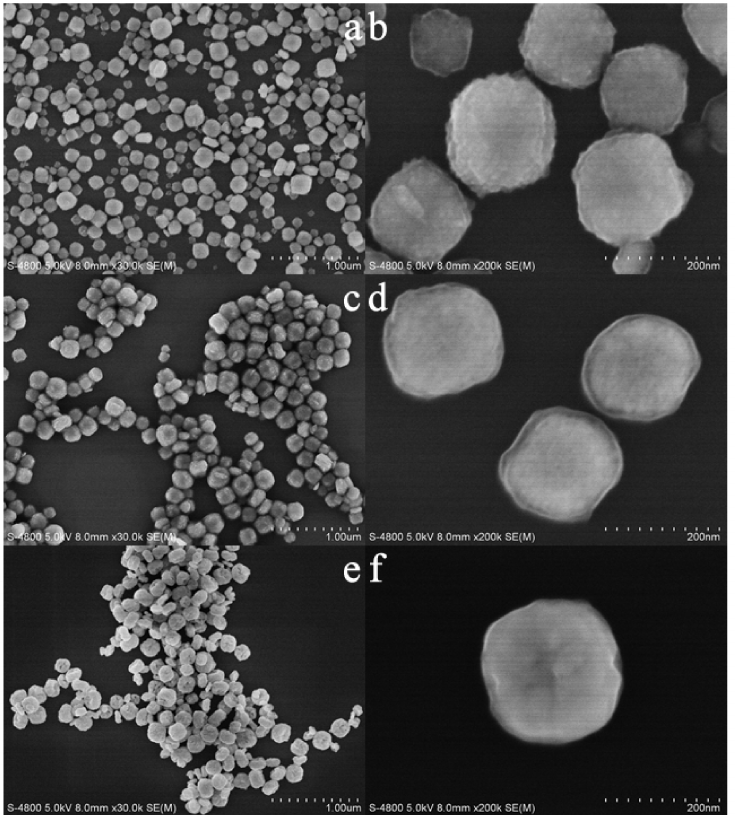
Figure 2. FESEM images of as-synthesized ( a , b ) and calcined zirconias ( c , d ) calcined at 723 K; ( e,f ): calcined at 923